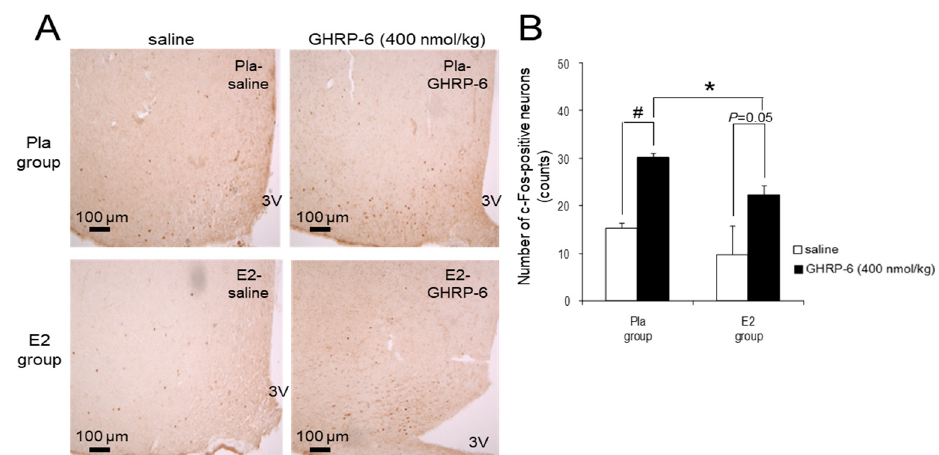
Figure 4. c ‐ Fos ‐ positive neurons in the arcuate nucleus (ARC) induced by intraperitoneal (IP) injection of growth hormone ‐ releasing peptide (GHRP) ‐ 6. ( A ) Representative images of c ‐ Fos ‐ positive neurons after IP injection of 400 nmol/kg GHRP ‐ 6 or saline in the ARC of high ‐ fat diet (HFD) ‐ fed rats in the placebo (Pla) ‐ saline, Pla–GHRP ‐ 6, 17 β‐ estradiol (E2)–saline, and E2–GHRP ‐ 6 groups. 3V, third ventricle. Scale bars: 100 μ m. ( B ) The number of the c ‐ Fos ‐ positive neurons in the ARC after IP injection of 400 nmol/kg GHRP ‐ 6 or saline in the Pla–saline ( n = 4), Pla–GHRP ‐ 6 ( n = 5), E2–saline ( n = 4) and E2–GHRP ‐ 6 ( n = 5) groups. Values are shown as the mean ± SE. Data were analyzed by two ‐ way factorial ANOVA, followed by a post hoc Tukey–Kramer test. * p < 0.05, differences between the E2 and Pla groups. # p < 0.05, differences between the GHRP ‐ 6 and saline groups.